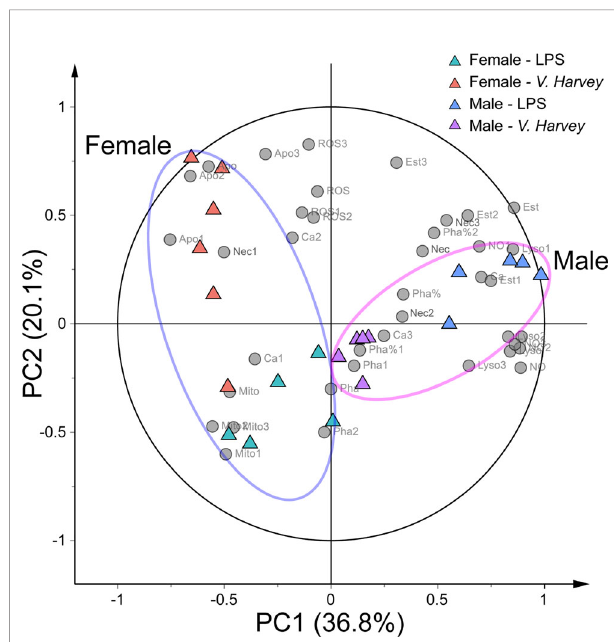
FIGURE 2 | PCA biplot showing the relationships among all immunological parameters and four exposure groups (LPS-infected males, LPS-infected females, V. harveyi -infected males, and V. harveyi-infected females) for all hemocyte subpopulations. 1, granulocytes; 2, semi-granulocytes; 3, agranulocytes. Mito, mitochondrial mass; NO, nitric oxideNO level; Ca, calcium content, Pha, phagocytic ratio; Est, esterase activity; ROS, ROS level; Lyso, lysosome mass; Apo, early apoptotic ratio; Nec, late apoptotic or necrotic